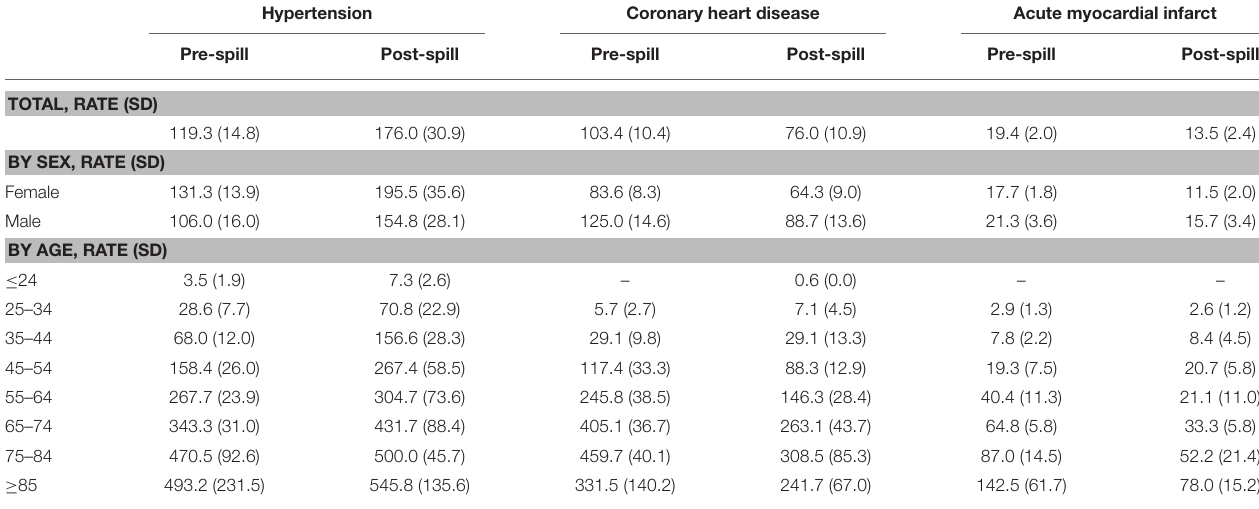
TABLE 2 | Mean annual rates (per 10,000 population) of cardiovascular hospital discharges for Graniteville area residents by diagnosis, gender, and age for the time period leading up to (2000–2004) and following (2005–2014) the chlorine gas release. Hypertension Coronary heart disease Acute myocardial infarct Pre-spill Post-spill Pre-spill Post-spill